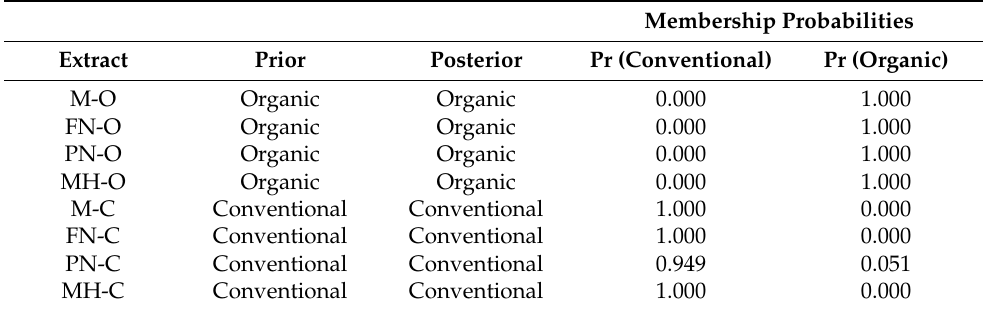
Table 6. Prior and posterior classification of the red grape seeds extracts using PC-DA (FTIR spectral data).